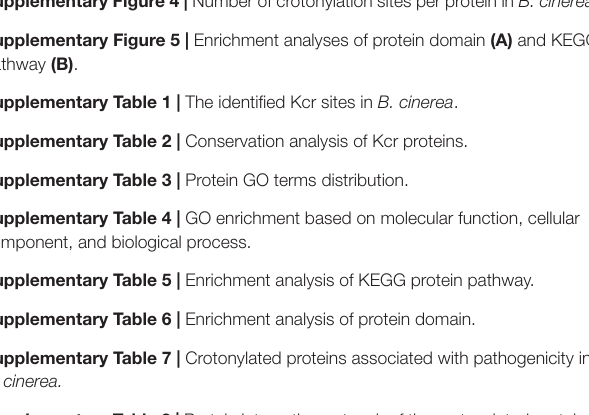
Supplementary Table 8 | Protein interaction network of the crotonylated